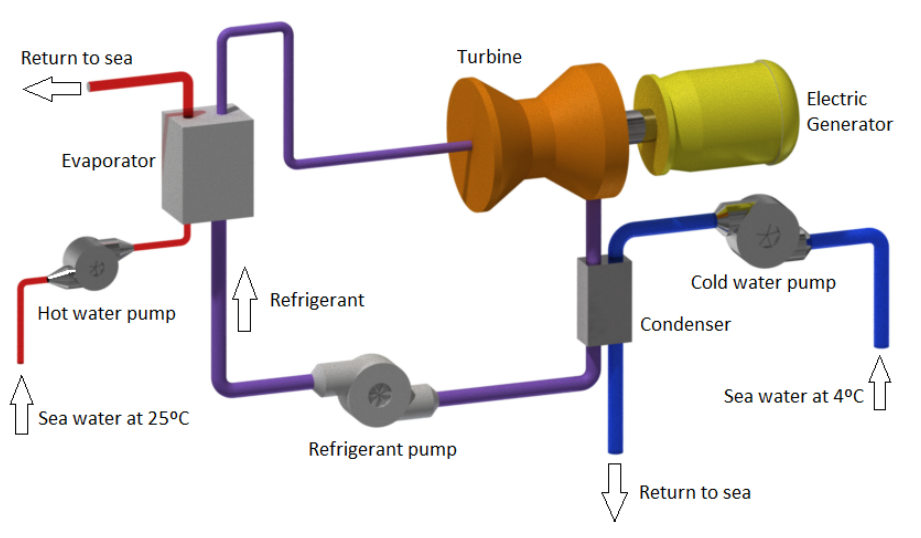
Figure 3. Closed-cycle OTEC scheme.